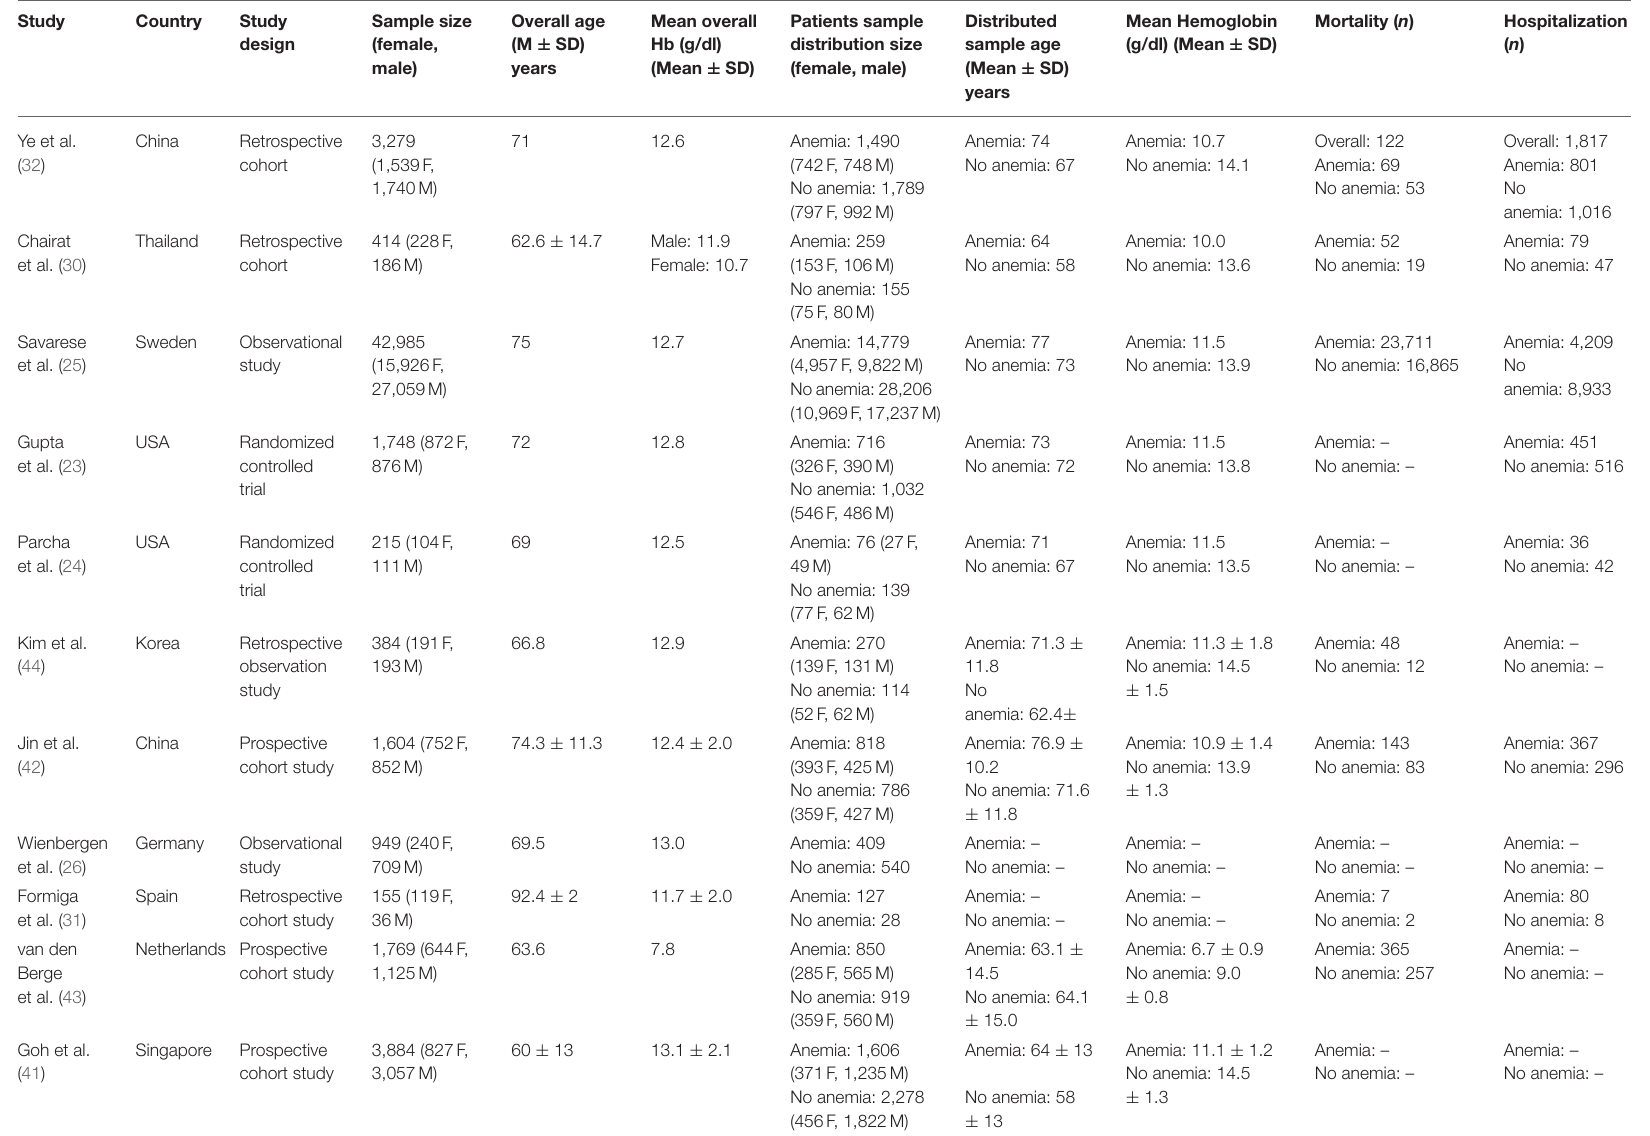
TABLE 1 | Details of the included